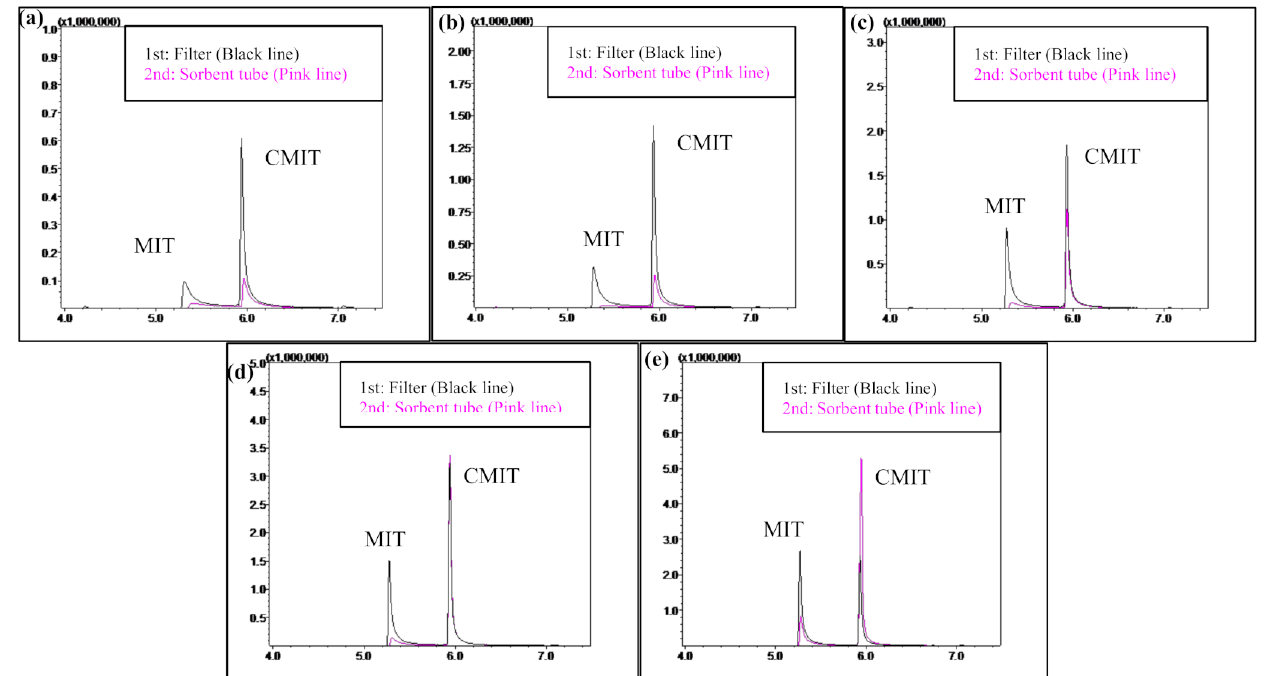
Figure 3. Chromatograms of the MIT and CMIT with different CMIT/MIT aerosol sampling volumes: ( a ) 3 L, ( b ) 6 L, ( c ) 10 L, ( d ) 15 L, and ( e ) 30 L; X-axis = retention time (min) and Y-axis = peak